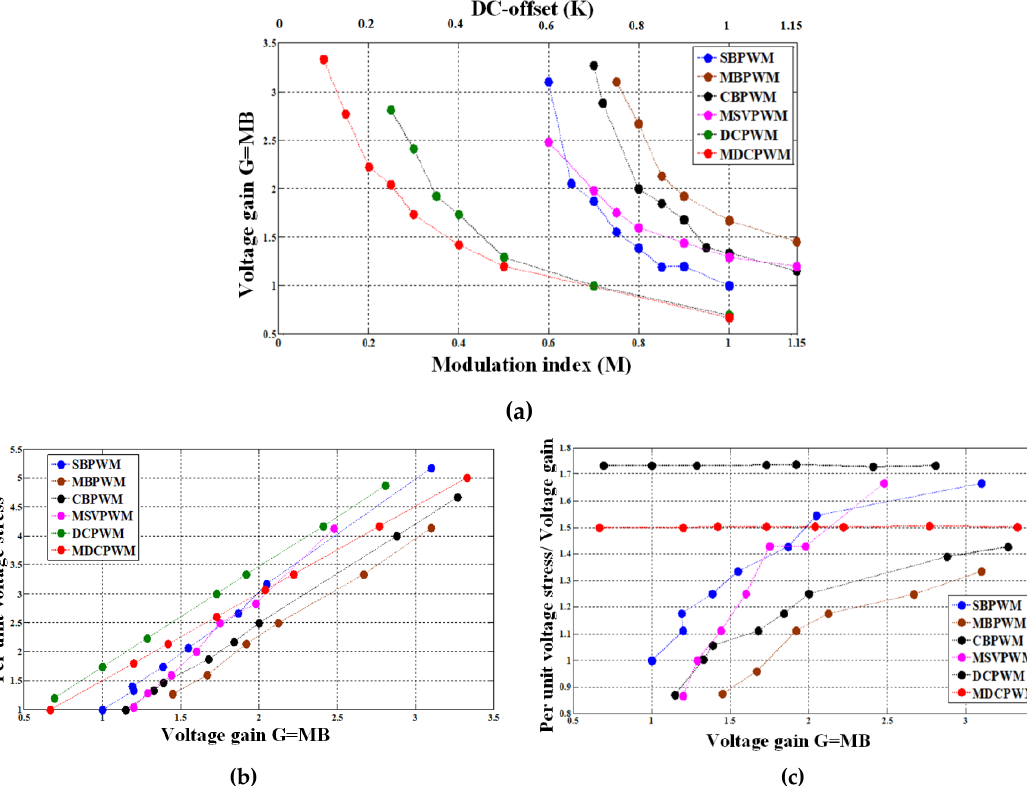
Figure 13. Experimental performance comparison for the investigated PWM techniques: ( a ) voltage gain versus control variable (M or K), ( b ) per-unit voltage stresses versus voltage gain and ( c ) per unit voltage stress / voltage gain versus voltage gain.